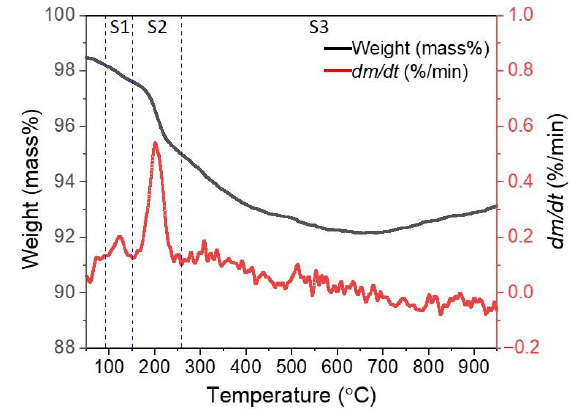
Figure 4. Weight percentage and reactivity rate curve of dehydrated iron ore at a heating rate of 10 °C/min.